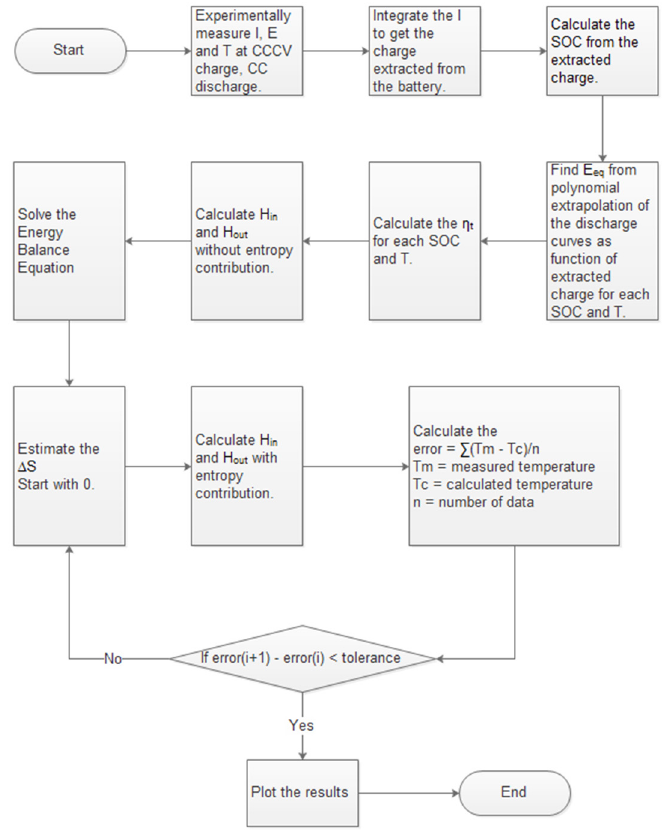
Figure 4. Experimental and modelling procedure for predicting the thermal behaviour of Li-ion batteries using this adaptive approach